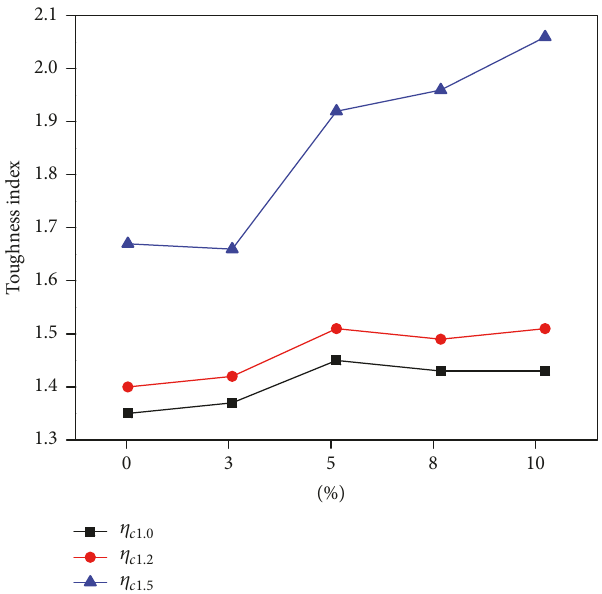
Figure 18: The toughness index of CaCO 3 whisker reinforced cement paste.